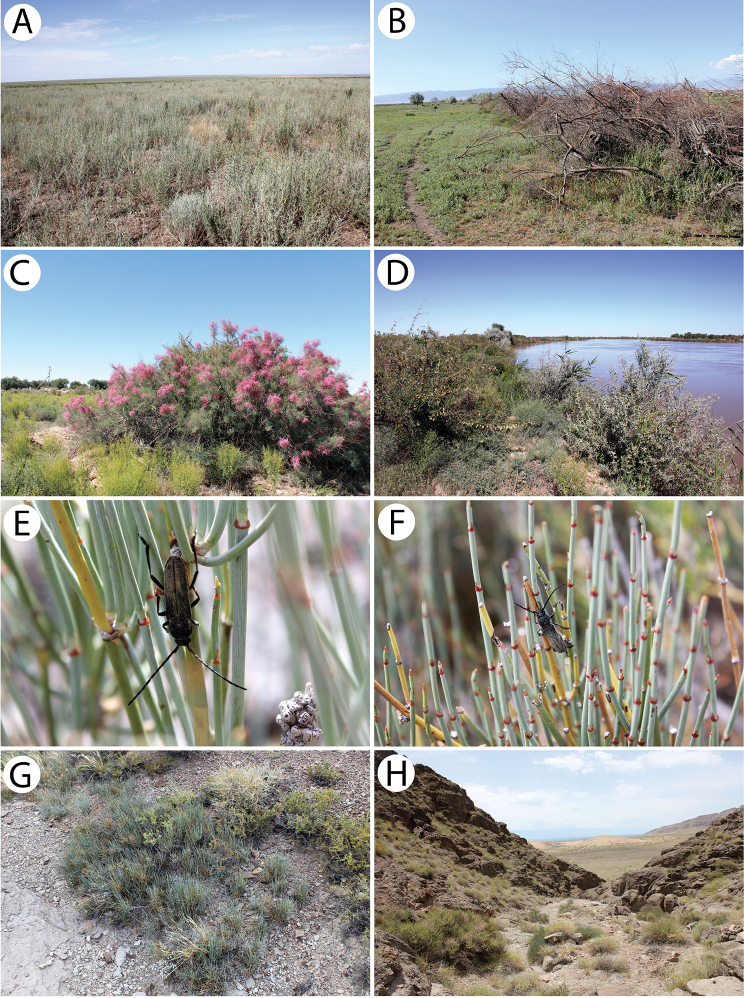
Field photos of imagines in nature, host plants and habitats of typical Kazakh cerambycid species: A semi-shrub desert in Kapchagay environs, the habitat of PsilotarsusbrachypteruspubiventrisB flood barrier formed with oleasters branches, the habitat of Turaniumscabrum and ChlorophoruselaeagniC blossoming tamarisks in the habitat of Ch.elaeagni and AnoplistesjacobsoniD bank of the Syr Darya River in Tartogay environs, the habitat of OberearuficepsruficepsE male of AnoplistesgalusoiFA.galusoi on EphedrastrobilaceaG shrubs of E.strobilacea, the host plant of A.galusoiH mountain slopes in Altyn-Emel National Park, the habitat of A.galusoi.